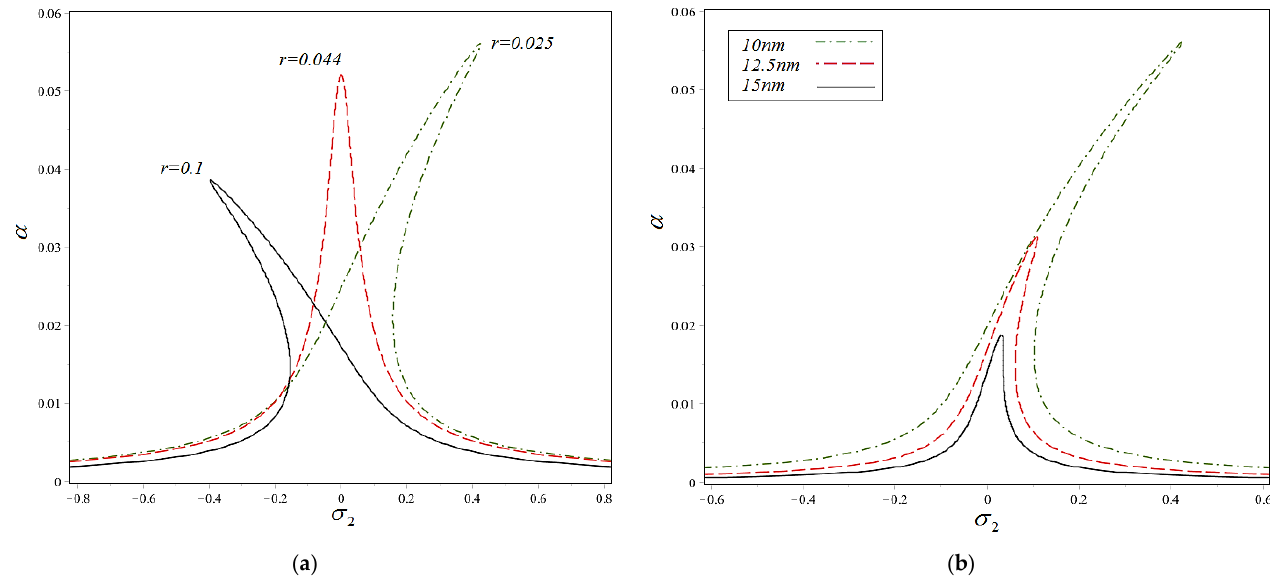
Figure 7. ( a ) Quadratic curvature waviness effect on the response of the primary resonance; ( b ) piezoelectric thickness effect on the response of the quadratic curve primary resonance.